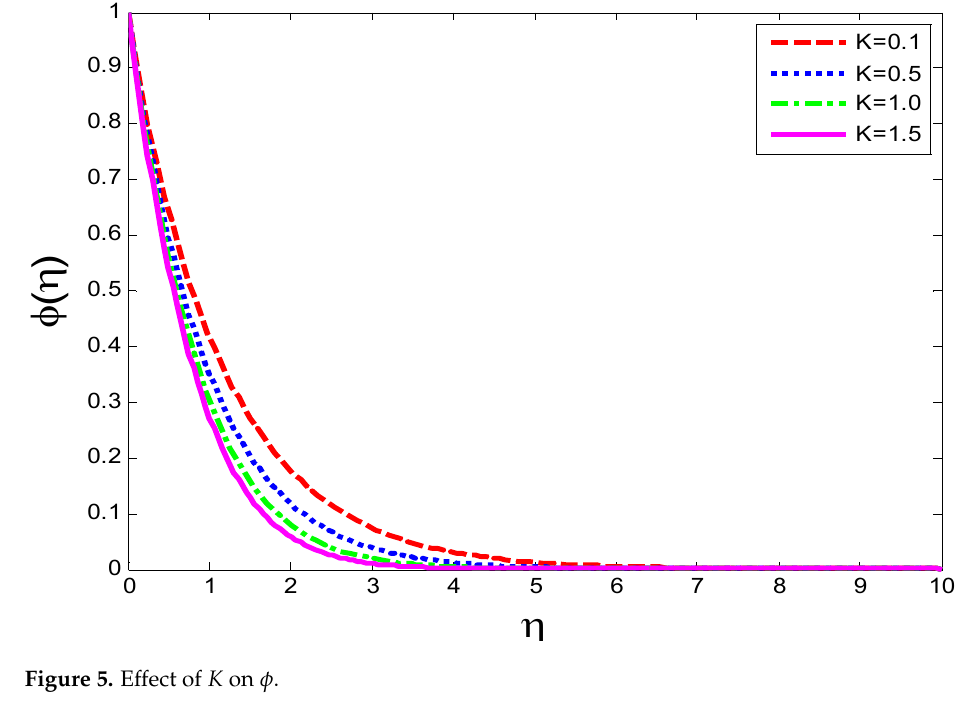
Figure 4. Effect 𝐾 on 𝑓 (cid:4593) (cid:4666)𝜂(cid:4667) .